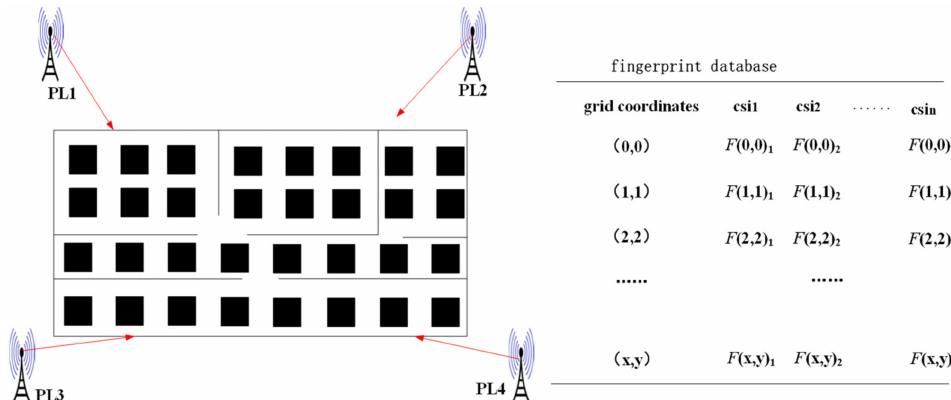
Figure 3. Establishment of location fingerprint